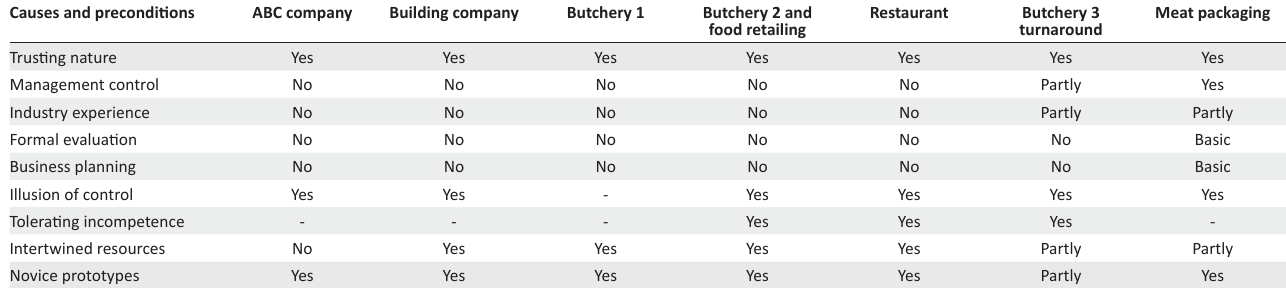
TABLE 2: Salient issues identified during the successive failures of ventures. Causes and